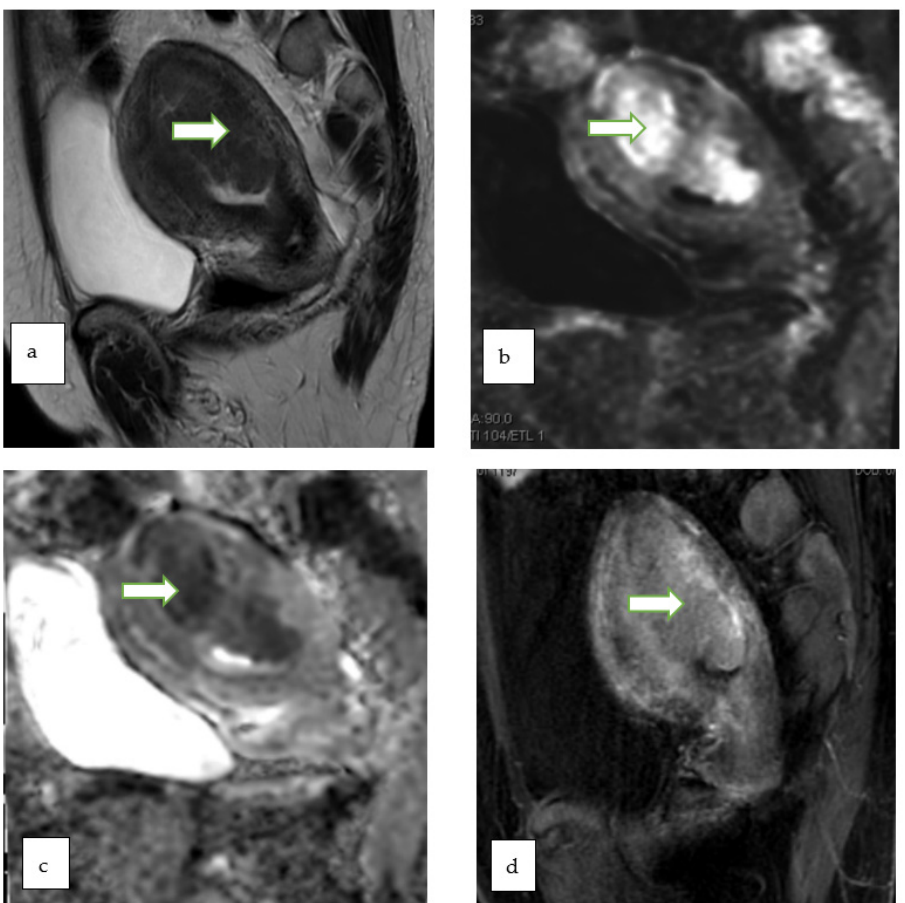
Figure 4. Sagittal T2W ( a ), DWI ( b ), ADC ( c ) and postcontrast fat saturated T1W ( d ) MR images of a 47 year lady with post menopausal bleeding show a hypoenhancing endometrial mass with diffusion restriction. There is <50% thick myometrial invasion along the posterior uterine wall. The patient underwent complete abdominal hysterectomy and pathology revealed endometrial endometrioid adenocarcinoma, with squamous